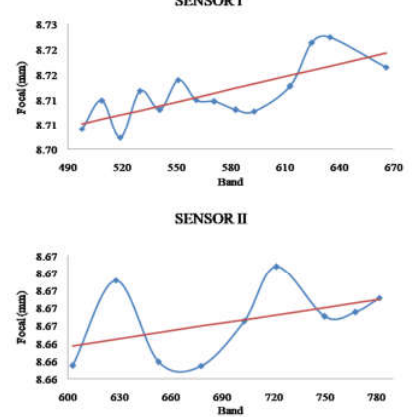
Figure 6. Estimated values for the focal lengths for both sensors and linear adjusted values.